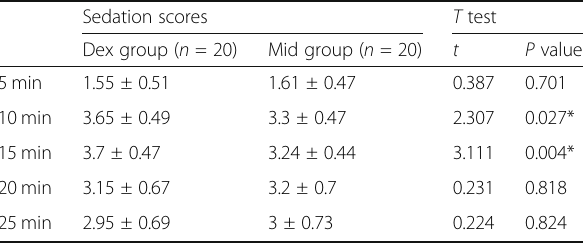
Table 2 Comparison of sedation scores between the study